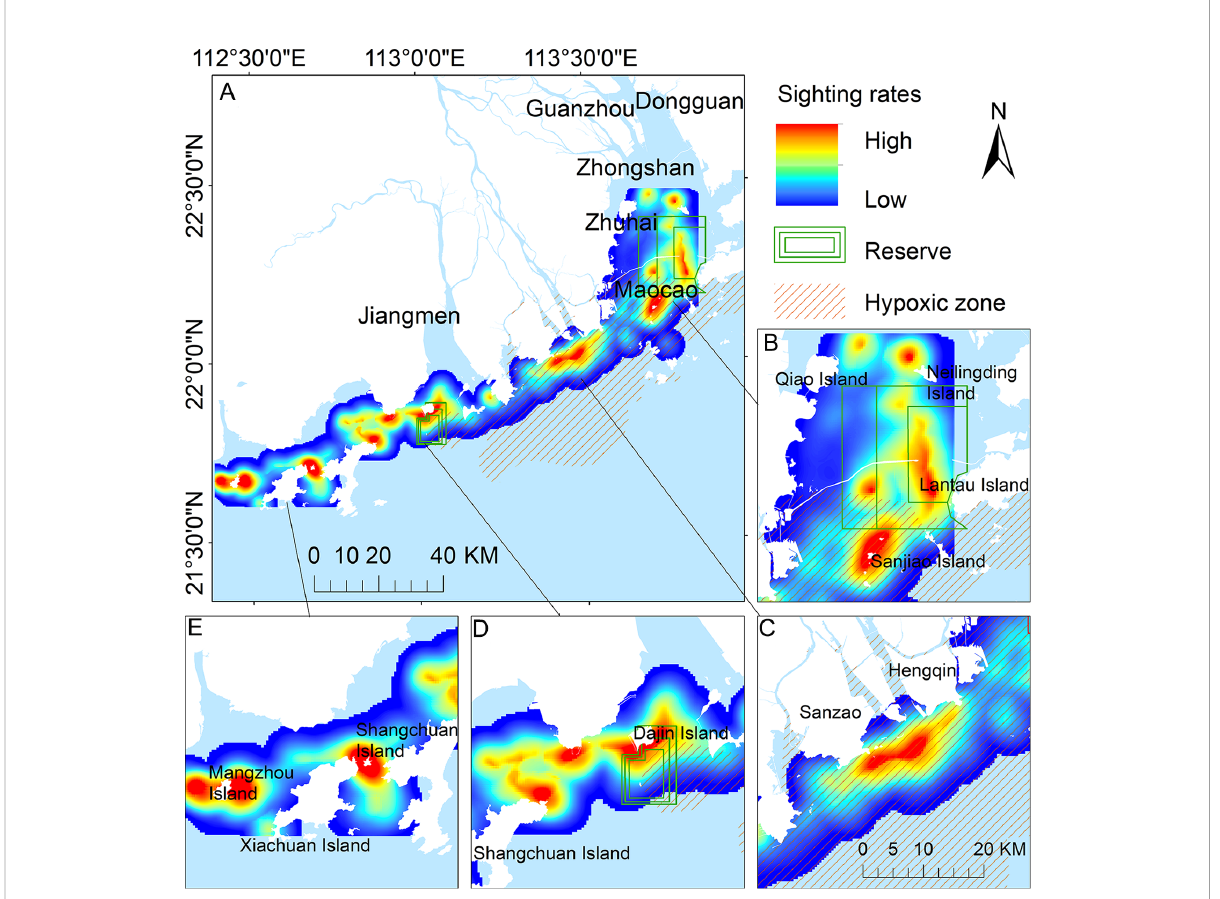
FIGURE 2 Spatial distribution patterns of sighting rates (sightings/surveys/km 2 ) of Indo-Paci fi c humpback dolphin by kernel density analyses in the Pearl River Estuary (PRE) from 2015 – 2021. Current reserve area (green boxes); hypoxic zone (orange shaded area); (A) entire PRE; (B) eastern PRE; (C) middle PRE; (D) Dajin and Shangchuan Islands in western PRE; (E) Shangchuan, Xiachuan,and Mangzhou Islands in western